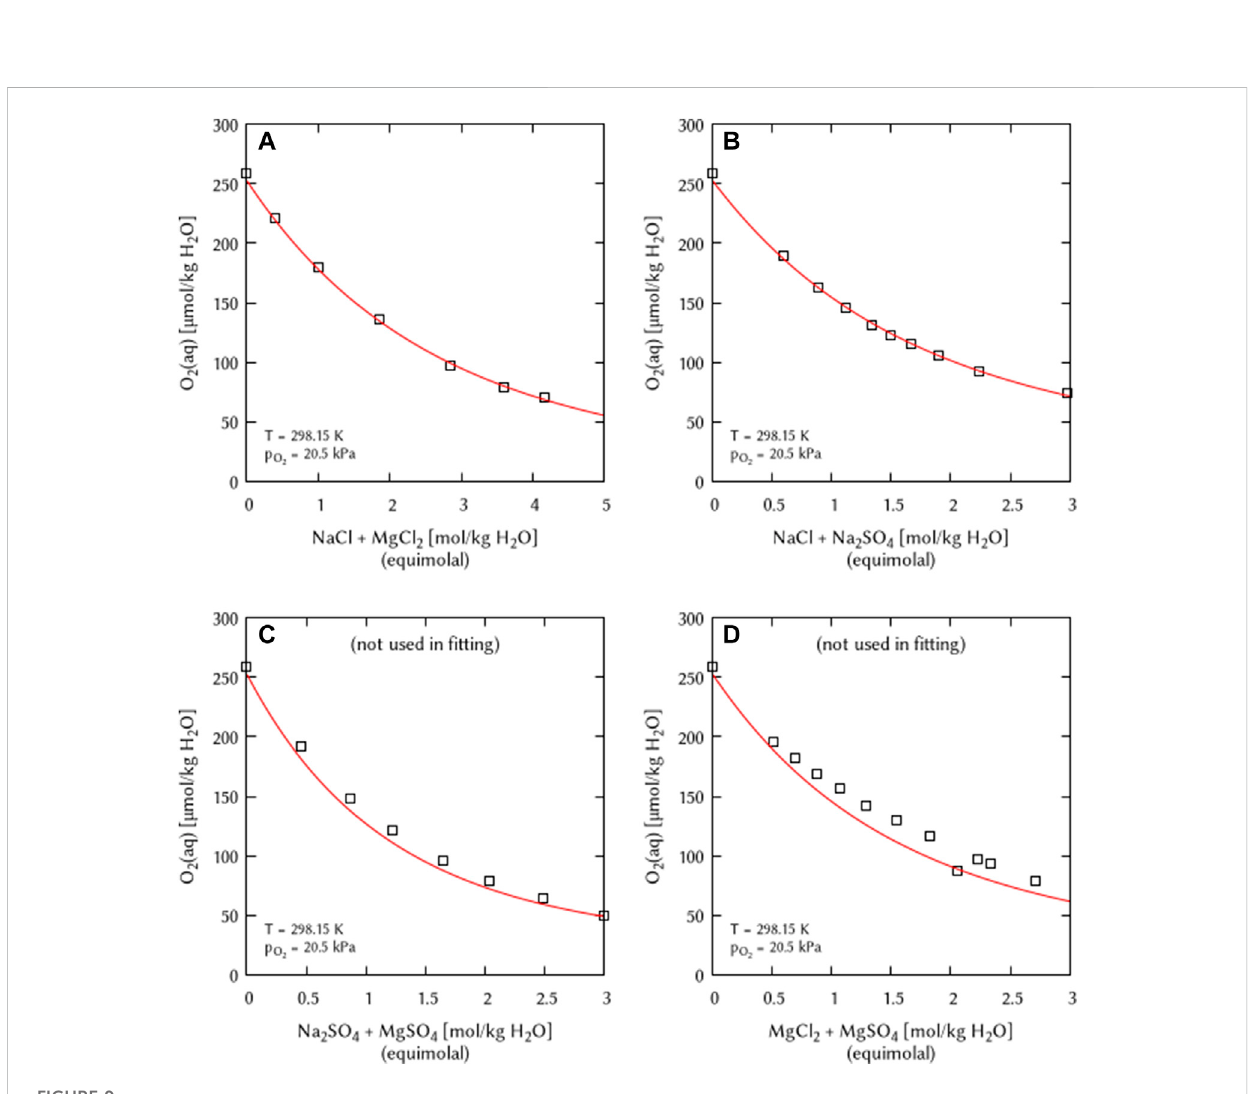
FIGURE 9 Modelling of the O 2 solubility in equimolal solutions of (A) NaCl + MgCl 2 , (B) NaCl + Na 2 SO 4 , (C) Na 2 SO 4 +MgSO 4 , and (D) MgCl 2 + MgSO 4 as a function of electrolyte concentration at T = 298.15 K (Points: Experimental data from □ Millero et al. (2002a), Lines: this work).